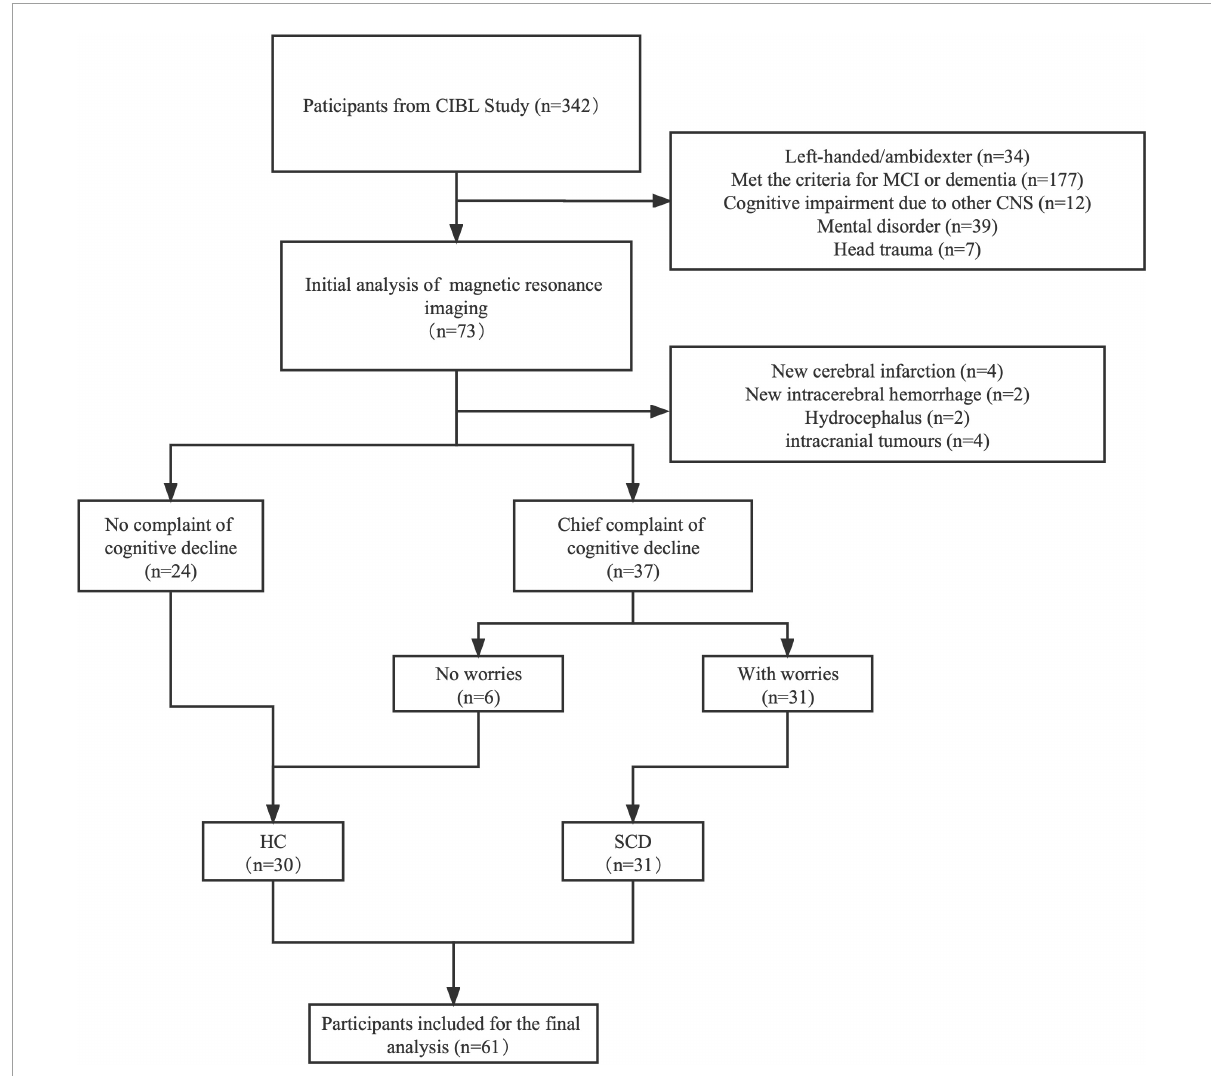
FIGURE1 A flowchart of the inclusion and exclusion criteria. MRI, magnetic resonance imaging; MCI, mild cognition impairment; HC, healthy control; SCD, subjective cognition decline.